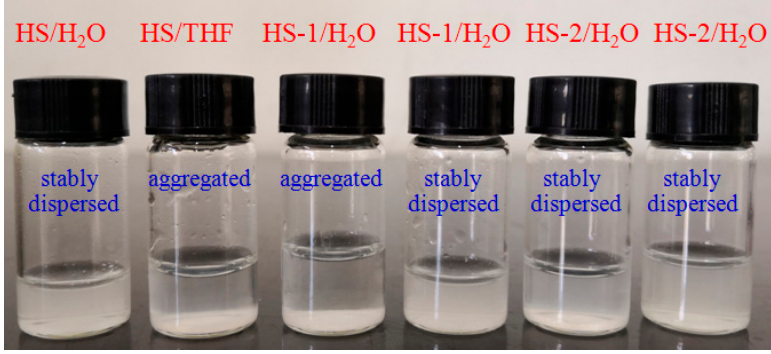
Figure 7. Dispersed/aggregated state of the hollow spheres samples in H 2 O/THF, respectively.